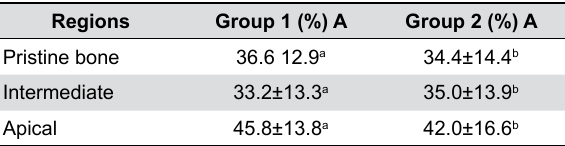
Table 1- Histometric outcomes of new bone formation after six months of bone repair in human maxillary sinus with the two